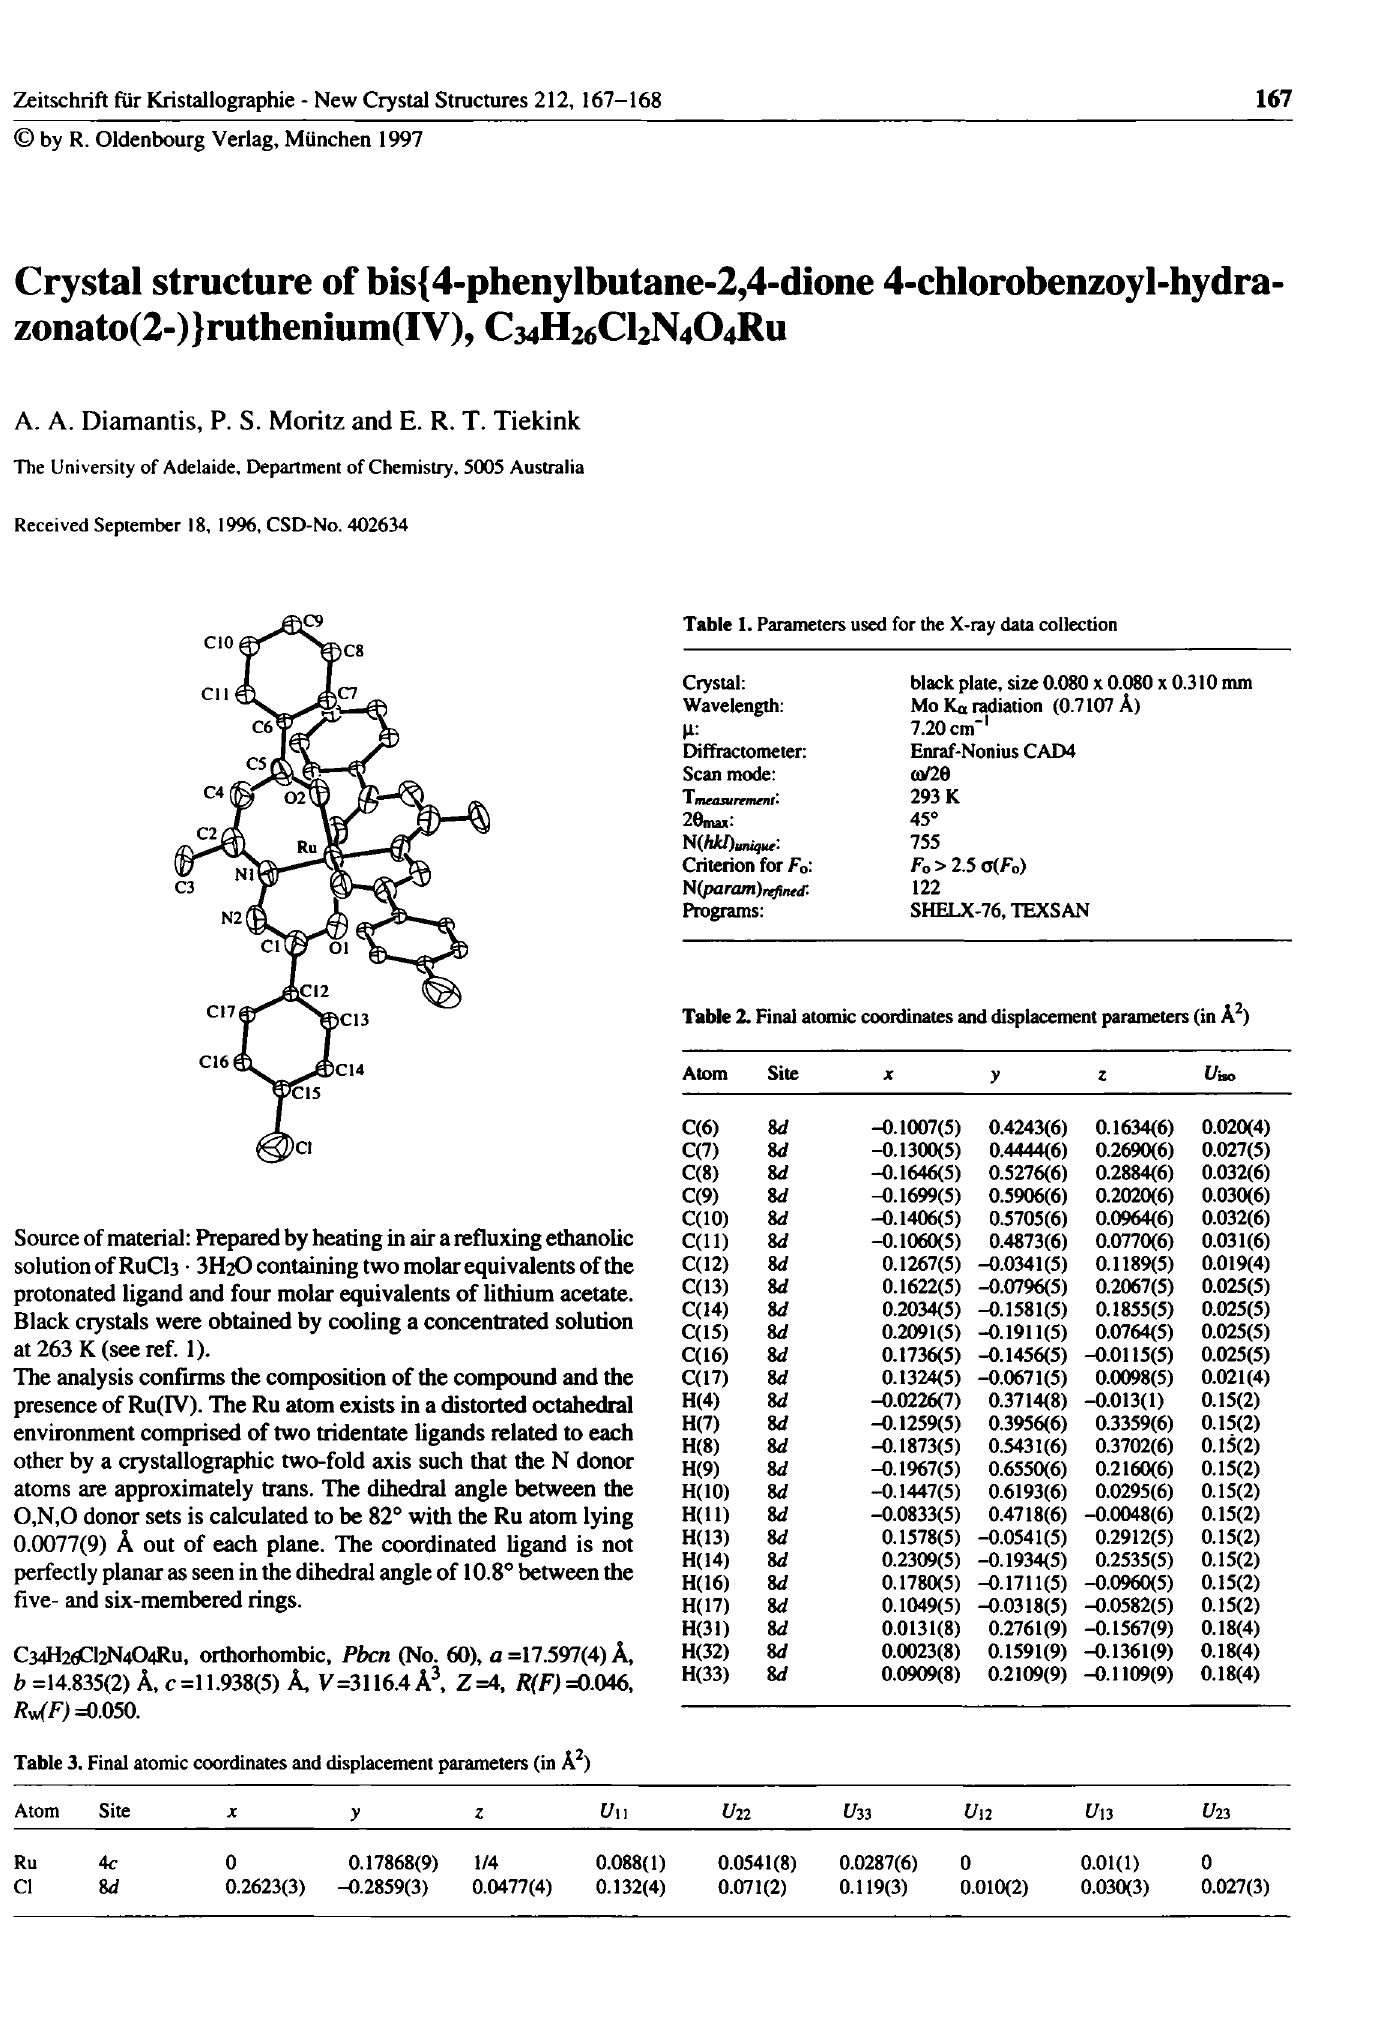
Table 3. Final atomic coordinates and displacement parameters (in Â 2 )